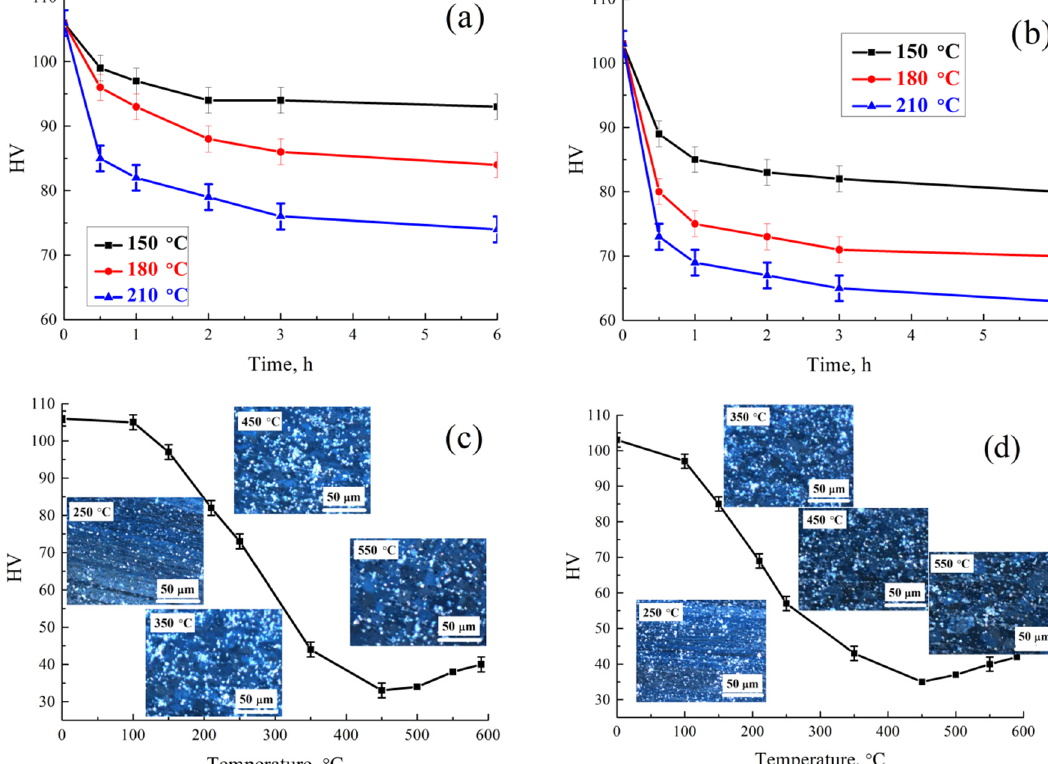
Figure 7. HV vs. time ( a , b ) and temperature (1 h) ( c , d ) dependencies of the rolled Al-Cu-Yb ( a , c ) and Al-Cu-Gd ( b , d ) alloys (inserts in c and d—grain structure after annealing at indicated temperature).